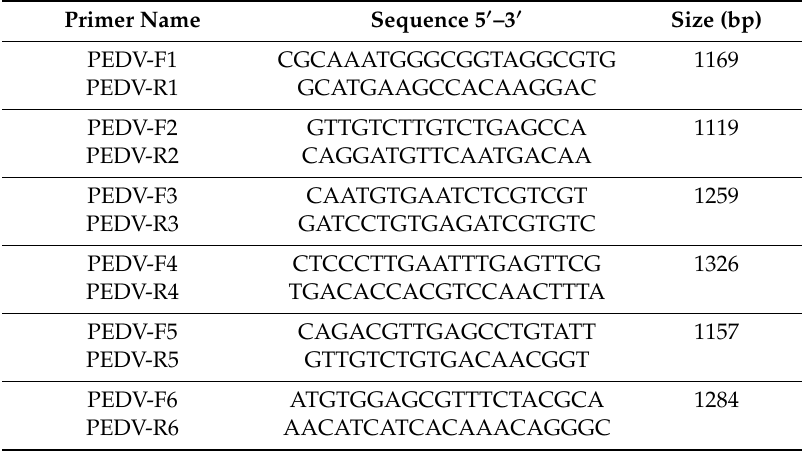
Table 1. Primers for SDSX16 complete genes